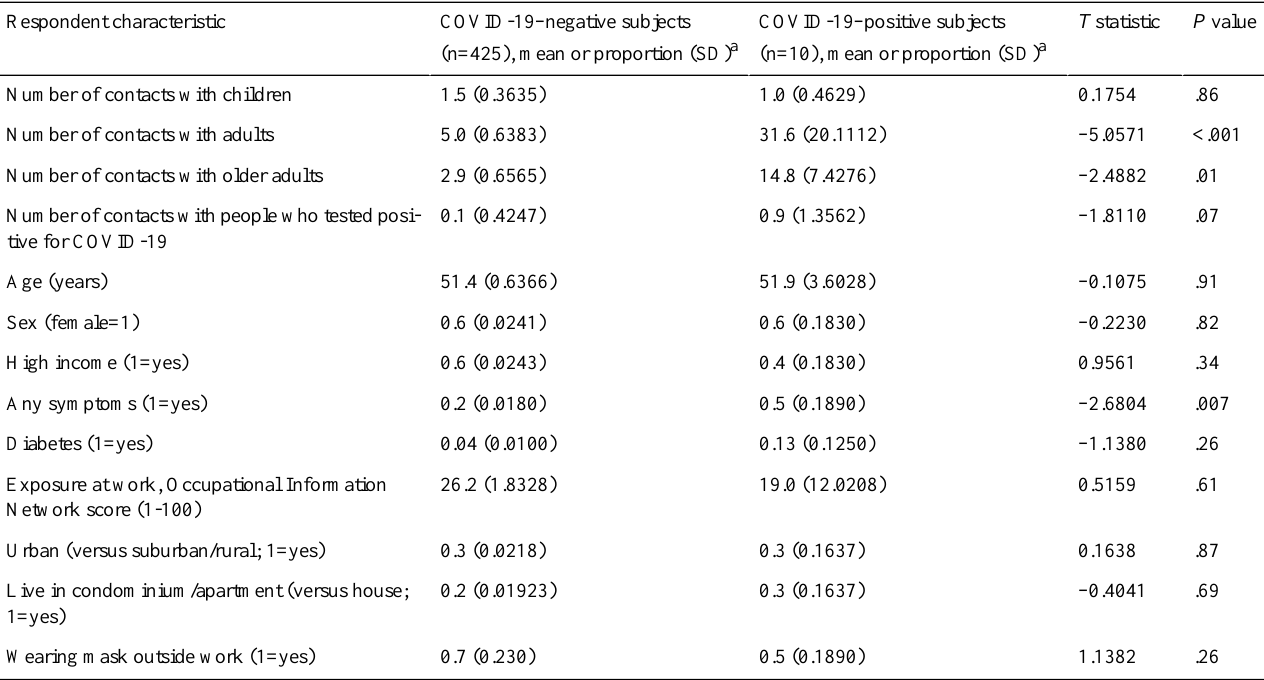
Table 1. Descriptive statistics from the sample of 435 survey respondents showing frequencies and percentages in different categories of risk factors associated with COVID-19 infection in Vermont between April 20 and May 13,